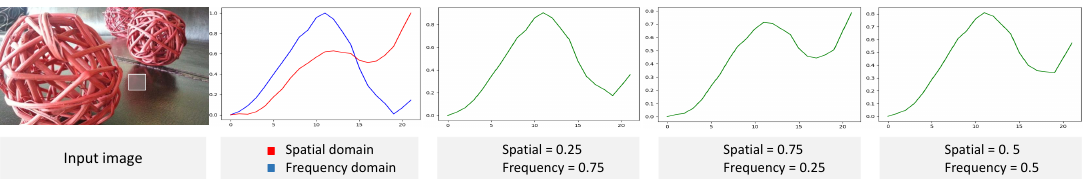
Figure 4. Difference between reference frame and other frames on less textured part of the image (marked with rectangle). Each graph: x axes—frame index; y —axes difference between reference frame and others (normalized between 0 and 1). From left to right: one of the input image, frame difference on frequency (blue) and spatial (red) domain, third to fifth: summation results after applying weight to both domain.